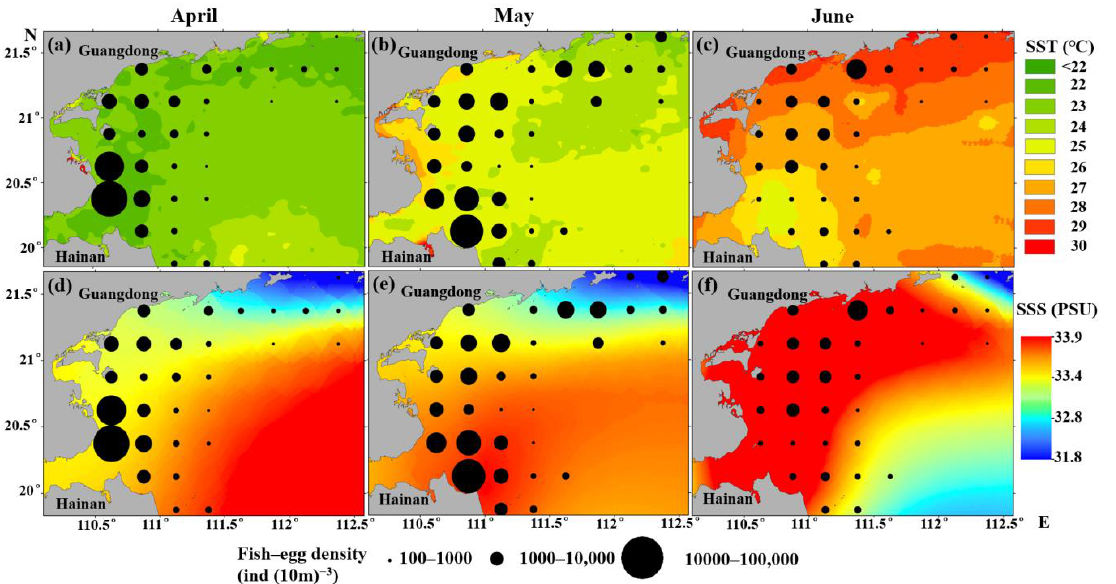
Figure 3. Relationship between the spatiotemporal distributions of the fish-egg density, water temperature, and salinity in WGWs: ( a) SST in April, ( b ) SST in May, ( c ) SST in June, ( d ) SSS in April, ( e ) SSS in May, and ( f ) SSS in June.